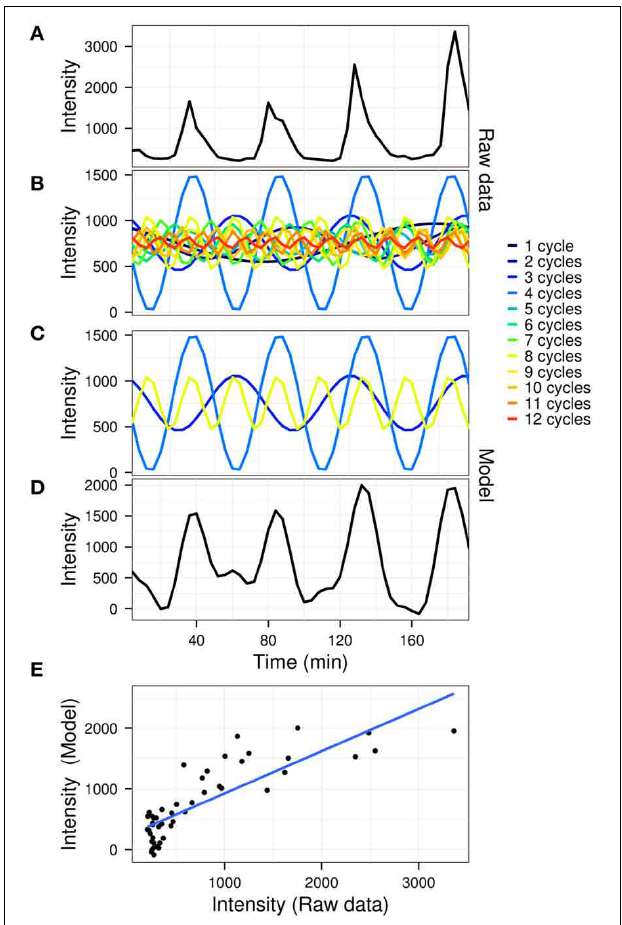
FIGURE 1 | A graphical representation of the model construction in untargeted mode. The raw gene expression time-series of gene YAL067C ( A ; arbitrary fluorescence units) is first decomposed by fast Fourier transform (B) . The significant powers which comprise the signal (C) are then recomposed to produce the model (D) . A linear fit is then used to determine the coefficient of variation ( E ; R 2 = 0 . 695) for the data (A) vs. the model (D)